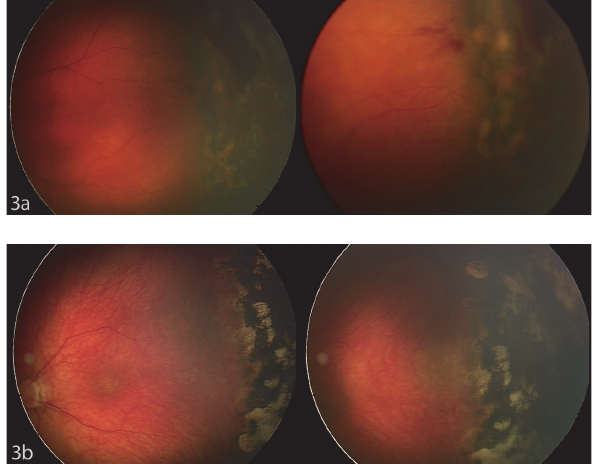
Fig. 3. Postoperative clinical findings two weeks (fig. 3a) and four weeks (fig. 3b) after the CALCR procedure. Images were taken with the RetCam 3 digital imaging